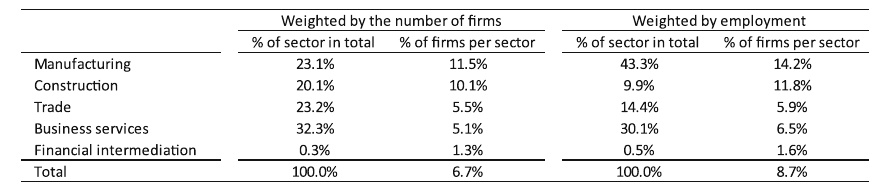
Table 1 Short-time work by sector and different